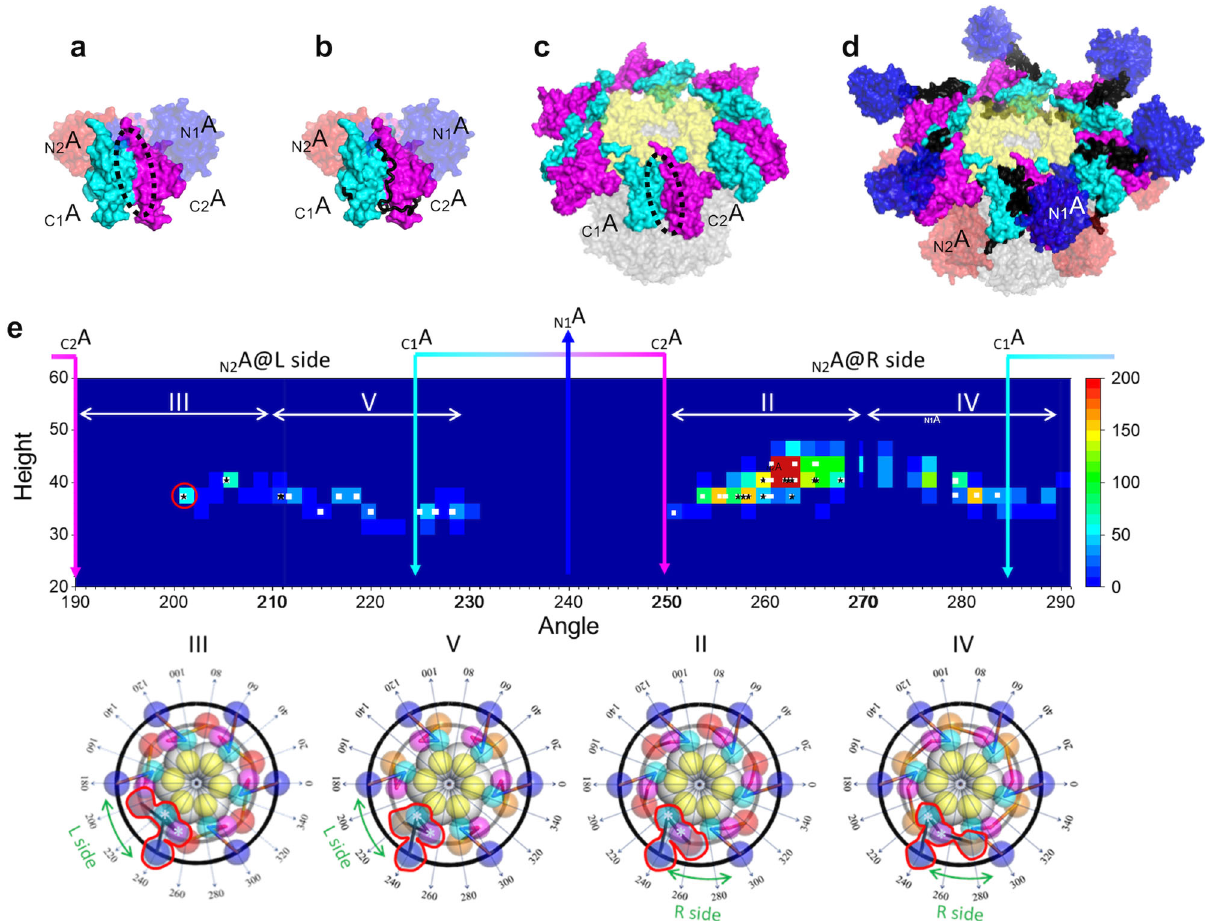
Fig. 7 Positioning sites of N A domains of A 2 protomers. a Hydrophobic surface (black dot circle) close to the dimeric interface of C A domains (cyan and magenta). b A complex of KaiA C-terminal domains (cyan and magenta) and disordered C-terminal segment of KaiC (black) (PDB code: 1suy). This is a part of A 2 C 6 complex. c Complex 1 (same as the cryo-EM structure). The hydrophobic surfaces to be exposed to solvent. d Model III-2. The hydrophobic surfaces are masked by the N1 A domains and the linkers. The coloring is as follows: N1 A (blue), N2 A (red), C1 A (cyan), C2 A (magenta), N A- C A linker (black), KaiB (yellow), and KaiC (gray). e (upper) Number distribution map of the N2 A domain connecting the asterisked C2 A domain (see lower inset) along the L ring of structure groups II – V: Horizontal and vertical axes are azimuth angle and height ( z -axis) in the ABC complex coordinates (see the lower insets). The number of N2 A domains is expressed of colors (see a scale bar). The white squares represent the models subjected to 10 ns MD simulation and the consequently veri fi ed models indicated by star marks. Red circle indicates the position of the N2 A domain in Model III-2. Cyan, magenta, and blue arrows indicate the positioning angles of the C1 A, C2 A, and N2 A domains, respectively. (Middle and Lower) The structural models of Groups II – IV as references. Colors of spheres for domains are the same as those in Fig.